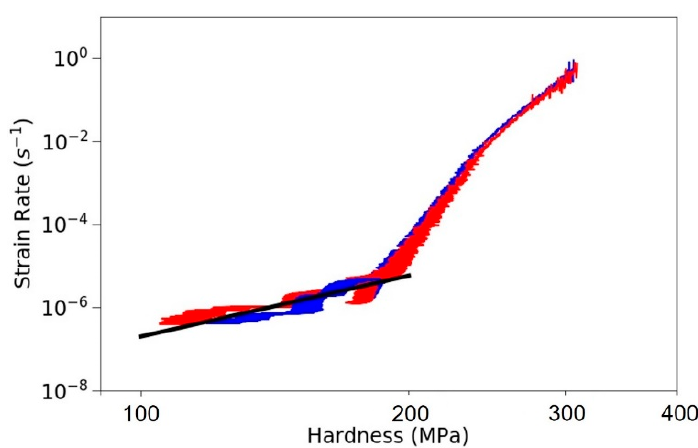
Figure 11. Hardness vs. strain rate data for the two very long hold experiments, which yielded the data shown in Figures 9 and 10. The black line is a best fit to the data at low stress, yielding a slope of 4.87 ± 0.91.